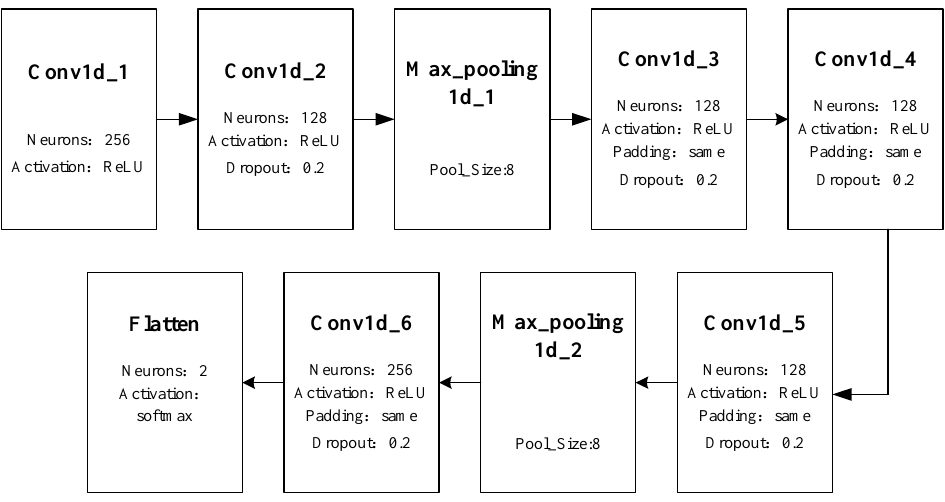
Figure 6. Neural network for bullying emotion recognition.